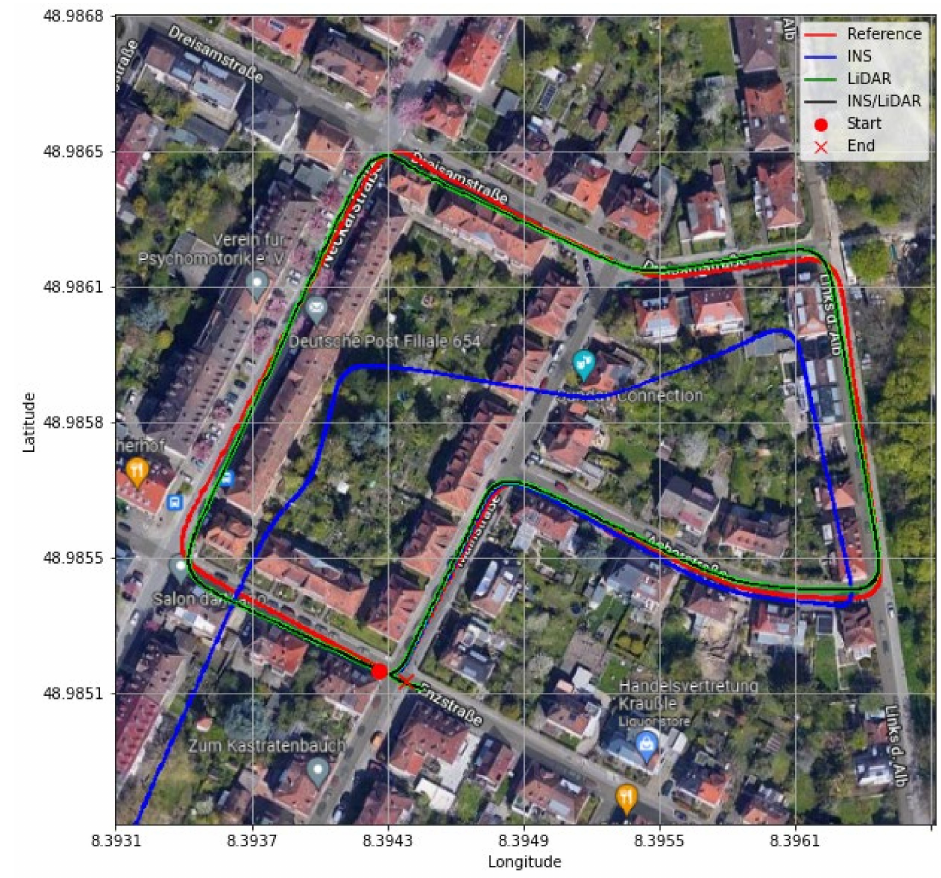
Figure 5. D-27—complete GNNS signal outage: comparison of trajectories.